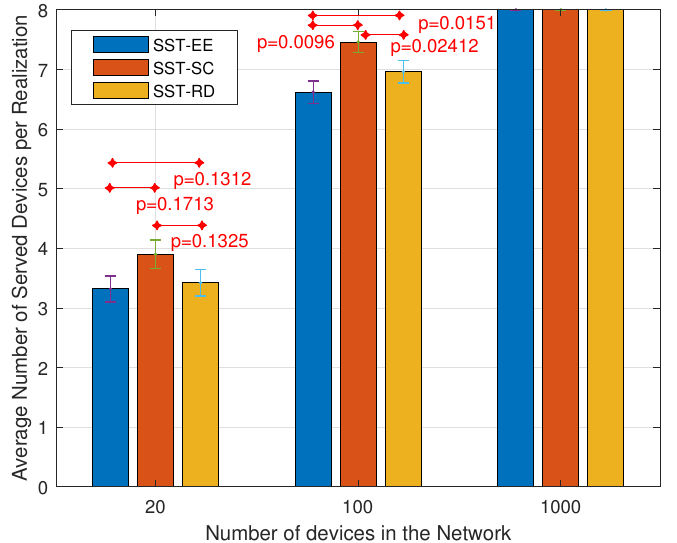
Figure 10. Variation in the average number of served devices per realization considering the